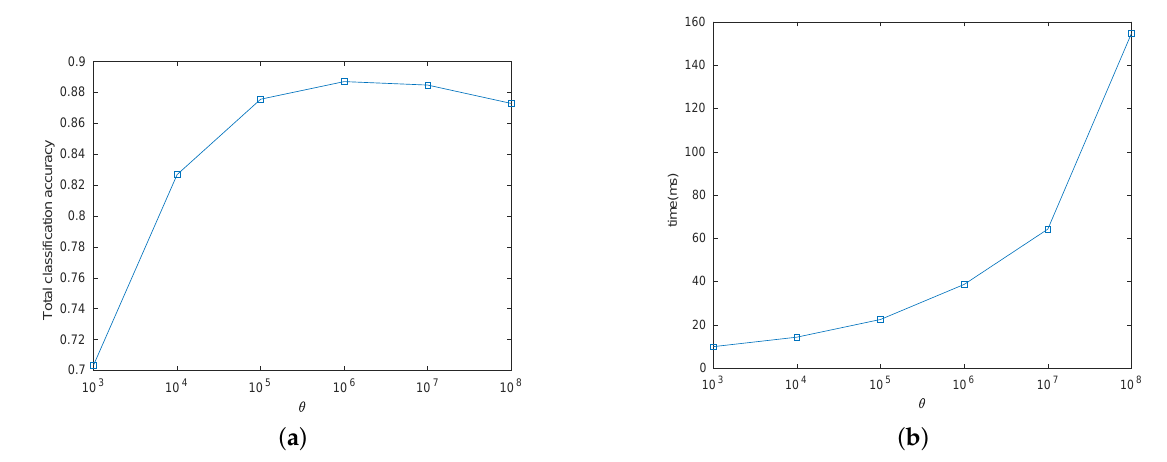
Figure 13. Accuracy and time-consuming versus varying scale parameter θ . ( a ) precision. ( b ) time